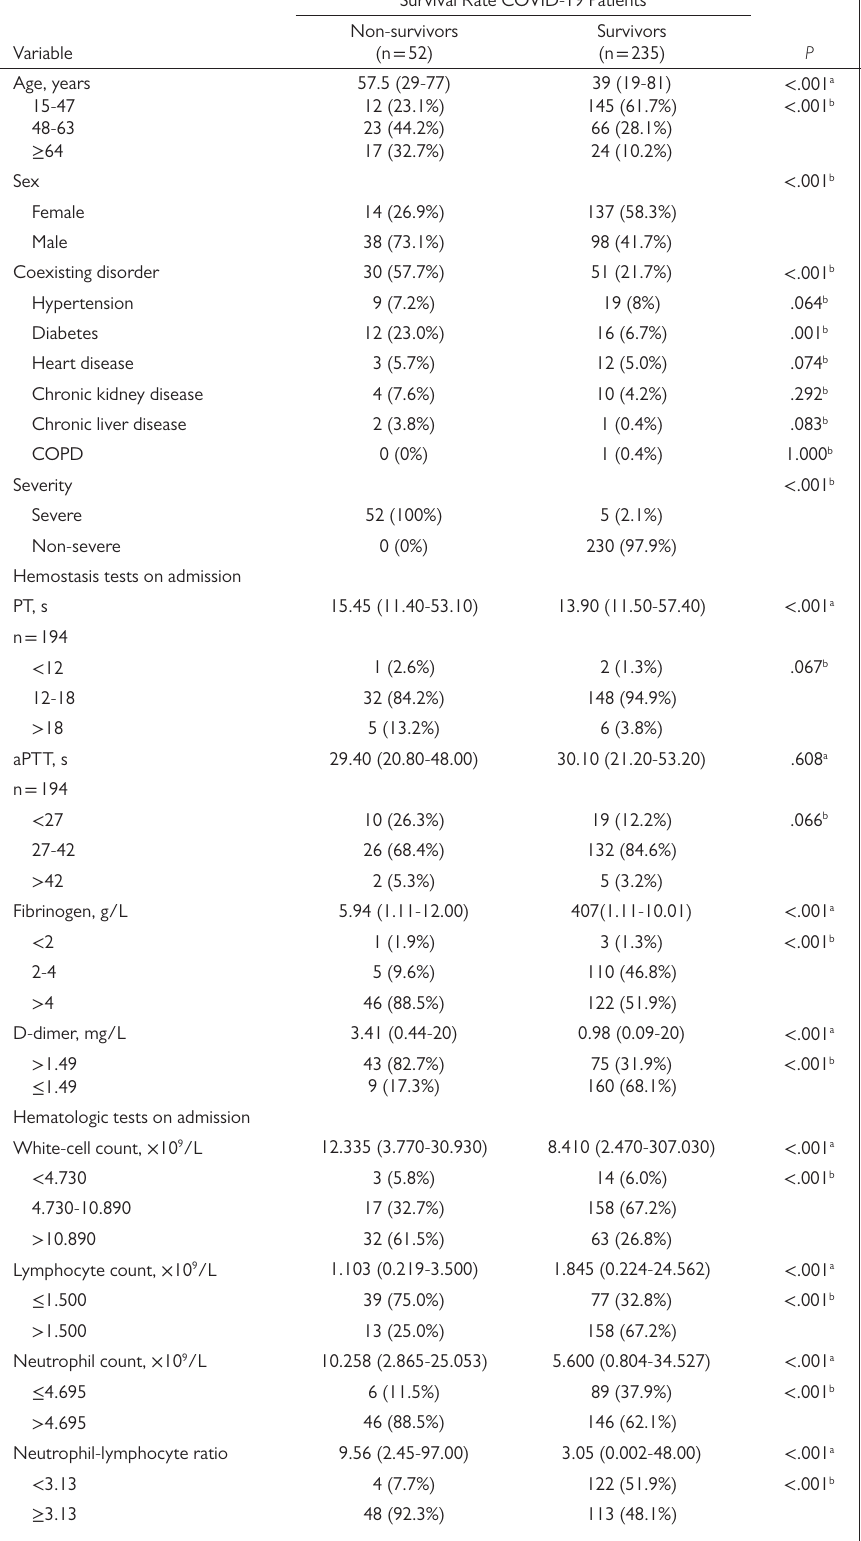
Table 1. Characteristics of COVID-19 Patients